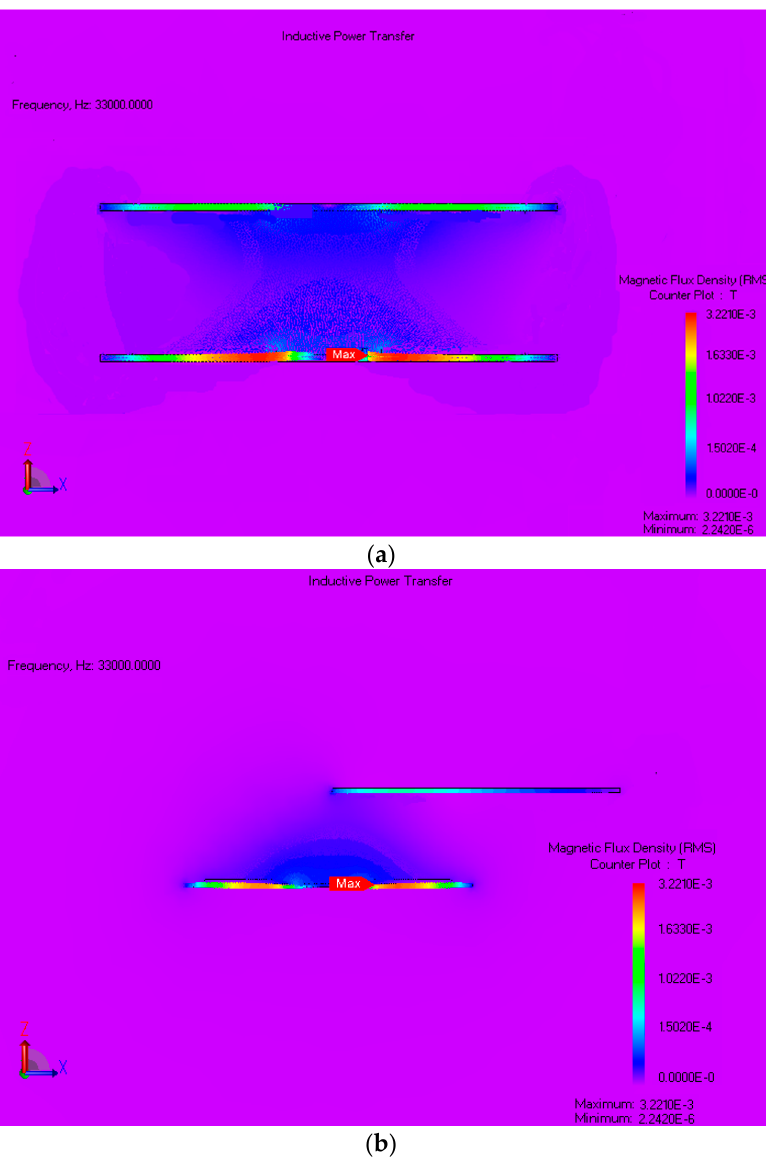
Figure 10. Magnetic Flux density ( a ) coils are perfect alignment; and ( b ) coils are misaligned to 50% of their size.